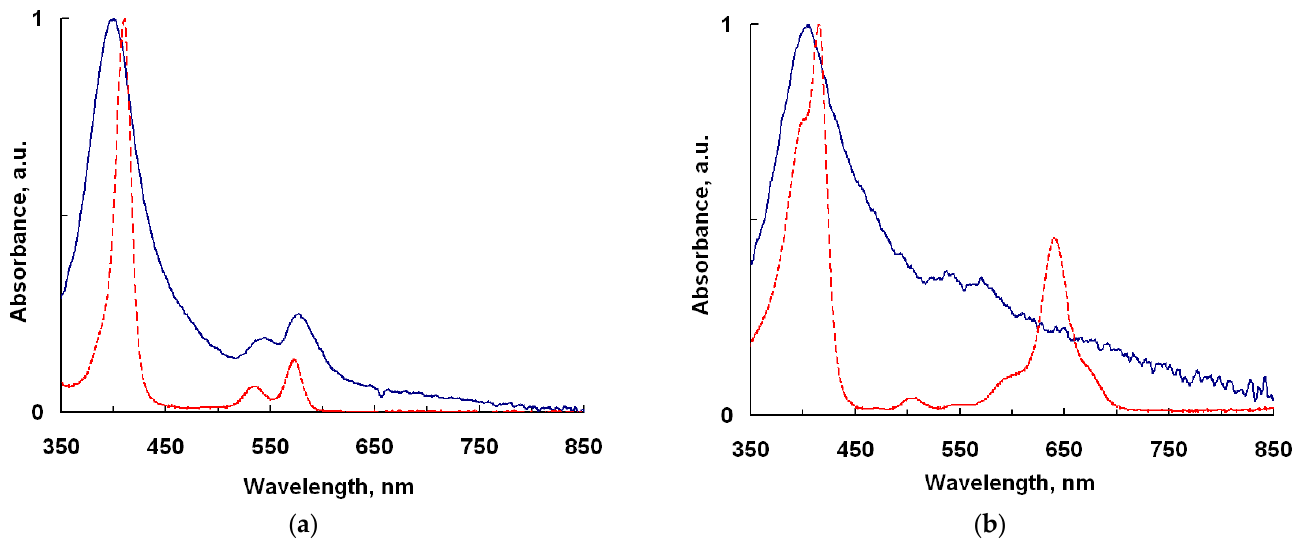
Figure 2. Cu-PP-IX ( a ) and Cu-C-e6 ( b ) normalized absorption spectra of the thin films (blue) deposited onto glass substrate by the RTE method and the solutions in chlorobenzene (red).